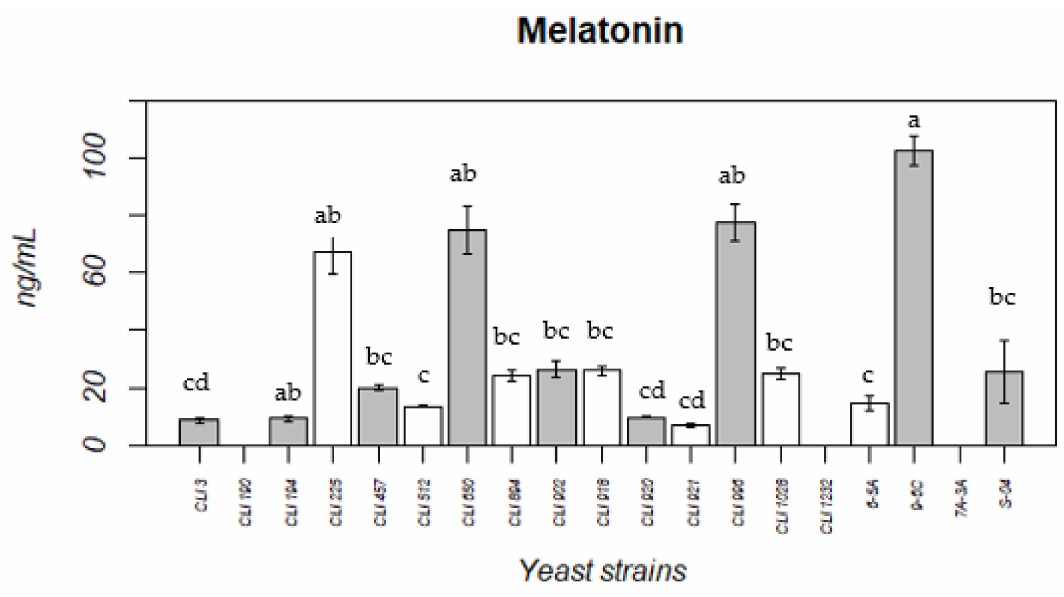
Figure 1. Melatonin content in the 18 selected yeast strains and S-04. Each value is the mean of three replicates expressed in ng mL − 1 . Data with different superscript letters are significantly different (Tukey tests: p <